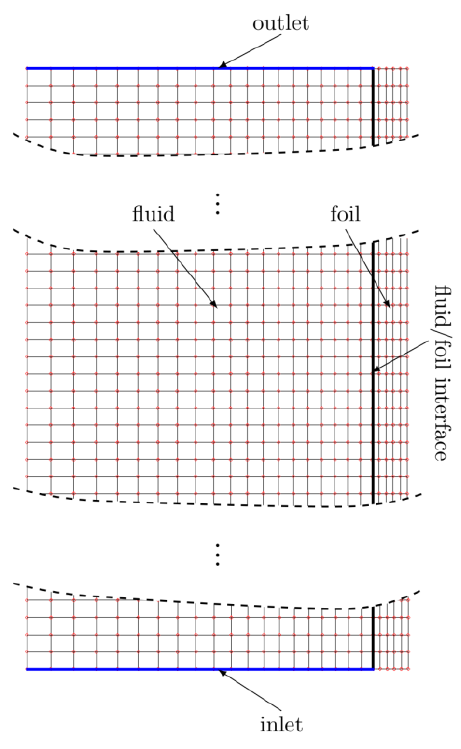
Figure 4. Typical FE mesh used in the finite element method FEM calculations.